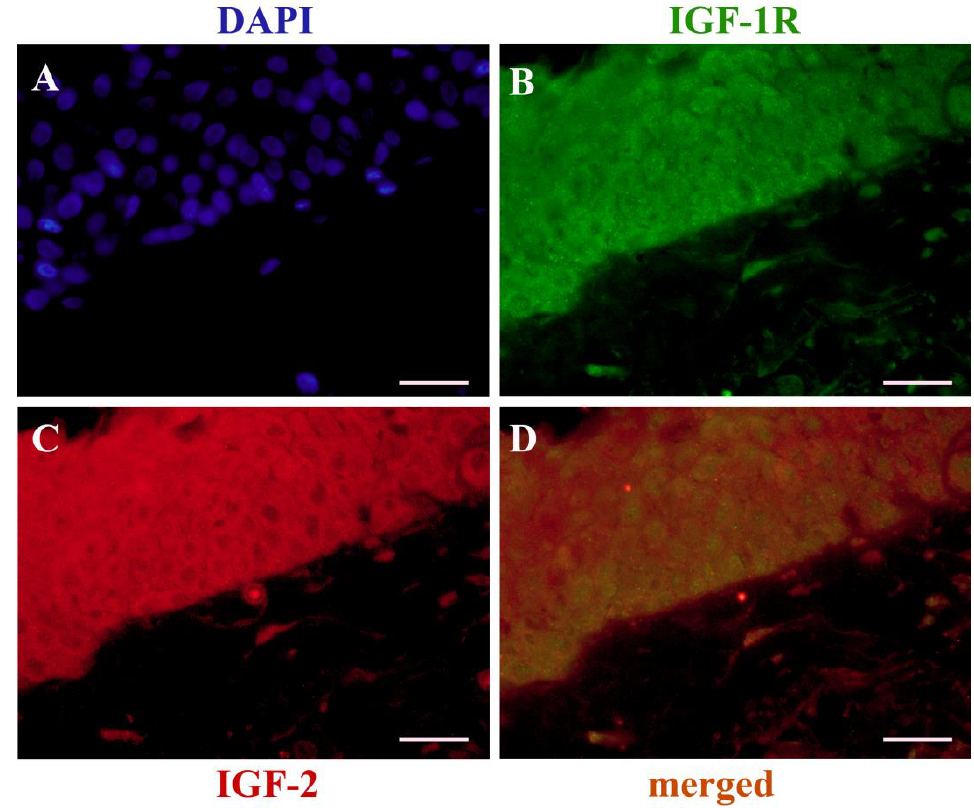
Figure 4. Immunofluorescence for IGF-2/IGF-1R in pterygium: ( A ) nuclei counterstained with DAPI (blue); ( B ) anti-human IGF-1R (green); ( C ) anti-human IGF-2 (red); ( D ) expression (yellow/orange) of IGF-2 and IGF-1R. ( A – D ): Scale bar= 20 µm.